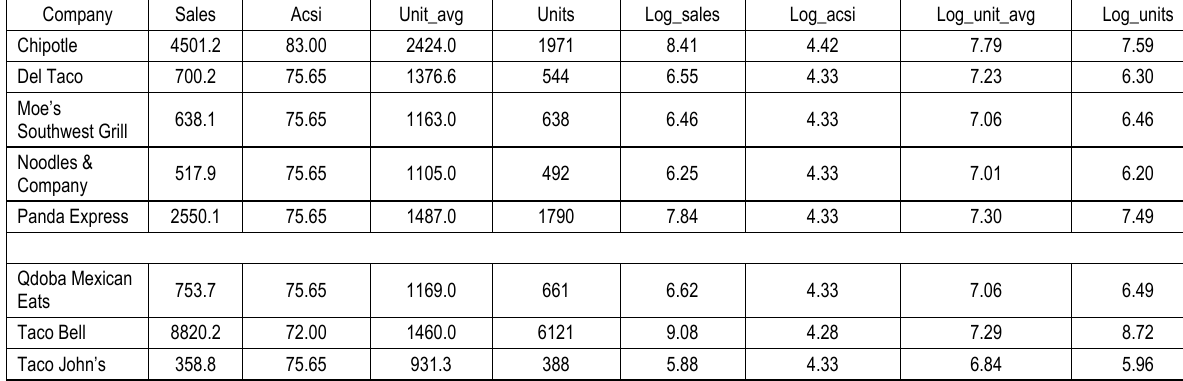
Table 14. Quick service restaurants (segment = ethnic)